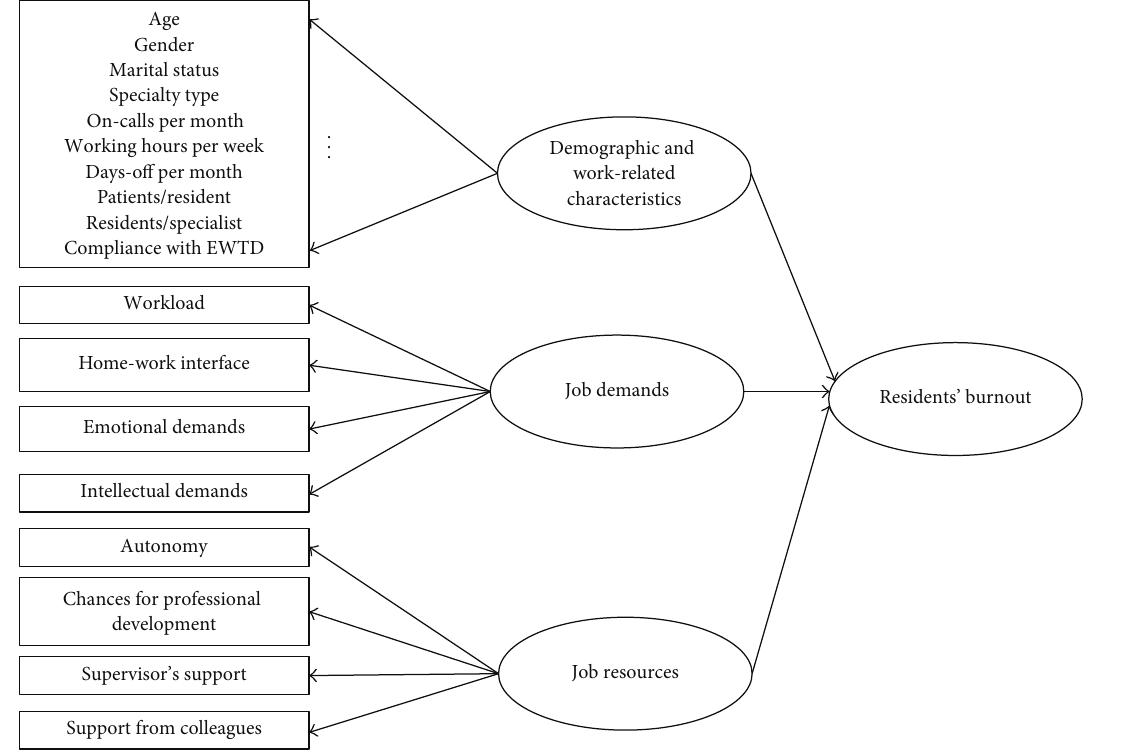
Figure 1: Conceptual model of residents’ burnout adopted in our